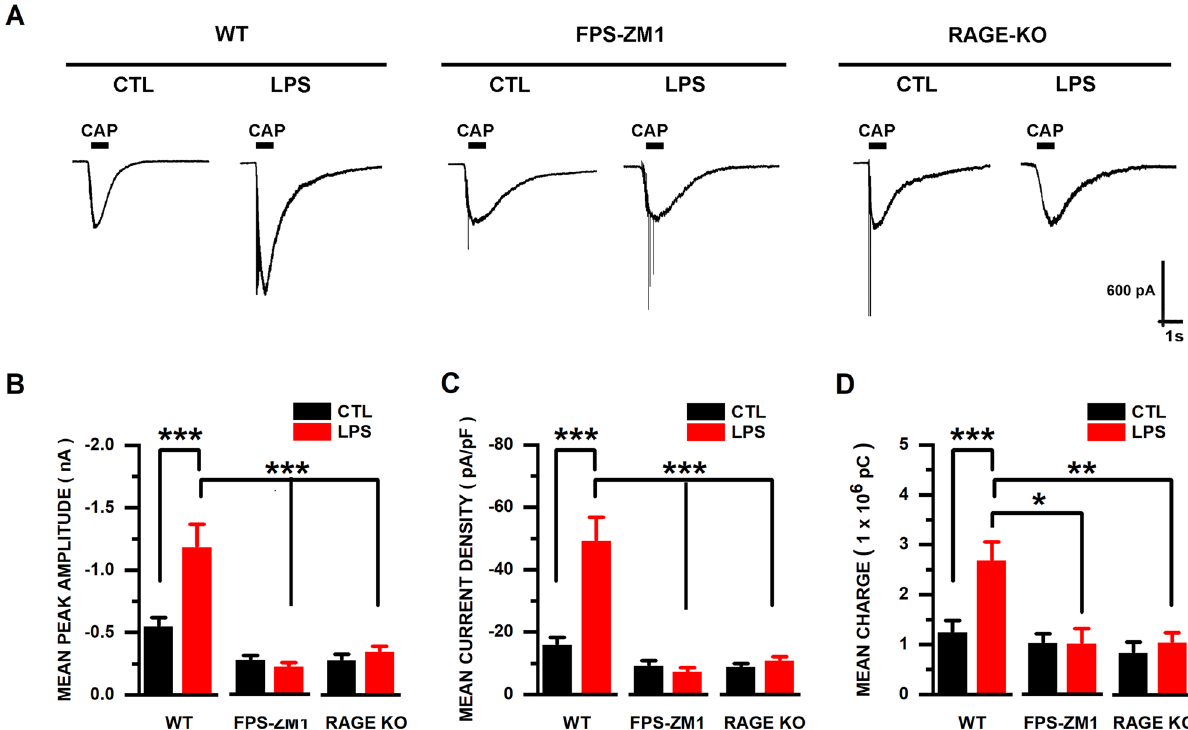
Figure 2. LPS exposure increases CAP-evoked currents in tDRG neurons from WT mice. ( A ) Representative CAP (1 µM; 1 s)-evoked current traces (V H = − 60 mV) from cultured wild type (WT), neurons from WT mice treated in vitro with RAGE antagonist (10 μm; FPS-ZM1), and RAGE-knockout (RAGE KO) neonatal mouse tDRGs. ( B ) Mean peak amplitude (pA), ( C ) current density (pA/pF) and ( D ) charge (1 × 10 6 pC) graphs of WT, FPS-ZM1, and RAGE KO tDRG neurons exposed to either control or LPS-containing media (1 µg/ml; 24 h). Treatment groups: WT control (n = 13); WT LPS (n = 9); FPS-ZM1 control (n = 6); FPS-ZM1 LPS (n = 5); RAGE KO control (n = 8); RAGE KO LPS (n = 9). Data represented as mean ± SEM. Means were statistically compared by 2-way ANOVA, followed by Tukey’s multiple comparison test; **p < 0.01; ***p < 0.001; ****p < 0.0001, 2-way ANOVA and Tukey’s test; Fig. 2A,B). Similar results were found by calculating the current density (CTL − 16.19 ± 2.16 vs. LPS − 49.49 ± 7.38 pA/pF; p < 0.0001, 2-way ANOVA and Tukey’s test Fig. 2C) and ionic charge (CTL 1.26 ± 0.22 vs. LPS 2.70 ± 0.35 × 10 6 pC/pF; p < 0.001, 2-way ANOVA and Tukey’s test Fig. 2D). However, when tDRG neurons from WT mice were incubated (48 h) with the RAGE antagonist FPS-ZM1 (10 μM) together with LP (24 h), CAP-evoked currents maintained in control conditions (n = 6) or incubated in LPS (n = 5) did not exhibit significant differences. The mean peak amplitude (CTL − 271.16 ± 28.50 vs. LPS − 218.23 ± 26.68 pA; p = 0.9996; 2-way ANOVA and Tukey’s test), current density (CTL − 9.44 ± 3.44 vs. LPS − 7.54 ± 2.50 pA/pF; p = 0.9997; 2-way ANOVA and Tukey’s test), or ionic charge (CTL 1.03 ± 0.70 vs. LPS 1.04 ± 0.39 × 10 6 pC; p = 0.9999; 2-way ANOVA and Tukey’s test) were not significantly different in the LPS group compared to controls. Further confirmation of our results with the RAGE antagonist were obtained in tDRG neurons from RAGE-KO mice. CAP-evoked currents in neurons maintained in control conditions (n = 8) or incubated in LPS (n = 9) did not exhibit significant differences. The mean peak amplitude (CTL − 282.12 ± 43.79 vs. LPS − 349.77 ± 41.71 pA; p = 0.9954; 2-way ANOVA and Tukey’s test), current density (CTL − 9.00 ± 0.88 vs. LPS − 10.94 ± 1.14 pA/pF; p = 0.9989; 2-way ANOVA and Tukey’s test), or ionic charge (CTL 0.86 ± 0.20 vs. LPS 1.07 ± 0.18 × 10 6 pC; p = 0.9924; 2-way ANOVA and Tukey’s test) were not significantly different in the LPS group compared to controls. Our results indicate that the lack of RAGE expression prevents the effects of LPS on CAP-evoked currents. LPS failed to increase neuronal excitability in tDRG neurons from RAGE KO mice. To test whether the LPS-induced excitability of sensory neurons required RAGE expression, we evoked action poten- tials in cultured neurons from both WT and RAGE KO mice (Fig. 3A–C). We quantified action potentials gen- erated by injection of depolarizing current steps (0–1000 pA, at 100 pA increments). Cultured tDRG neurons from WT mice treated with LPS displayed a significant increase in mean action potential counts at 200 pA (5.08 ± 0.96 counts; n = 12), compared to controls (2.42 ± 0.56 counts; n = 12; p = 0.0402; 2-way ANOVA and Tukey’s test; Fig. 3C). In contrast, in RAGE KO tDRG neurons there were no significant differences in action potential counts between the control (2.63 ± 0.60 counts; n = 16) and LPS groups (2.45 ± 0.58 counts; n = 11;